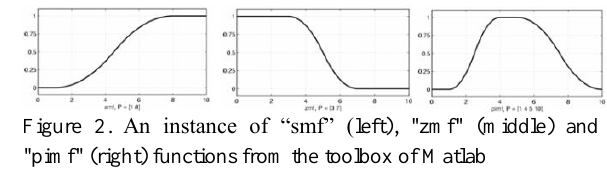
Figure 2. An instance of “smf” (left), "zmf" (middle) and "pimf" (right) functions from the toolbox of Matlab